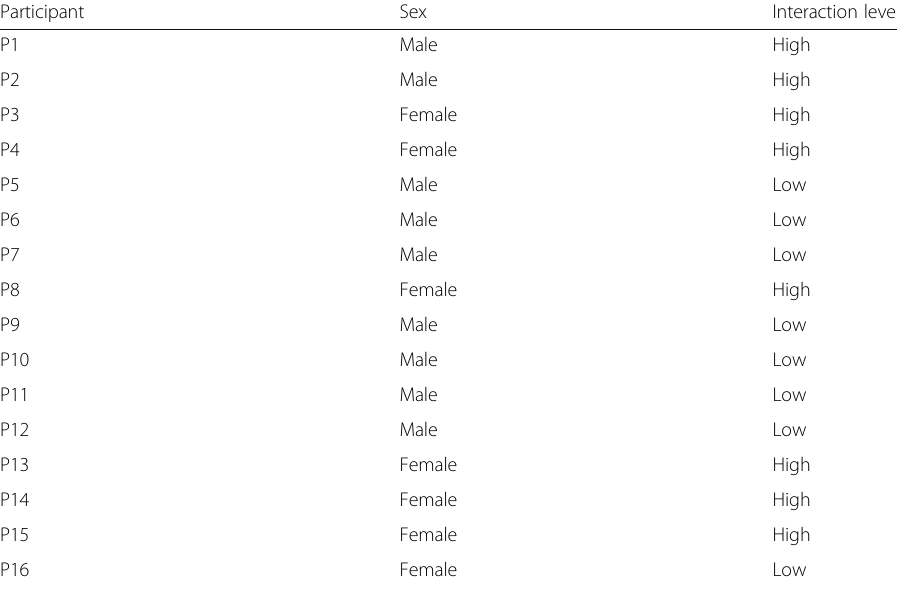
Table 4 Descriptive information about the learners who participated focus group interview